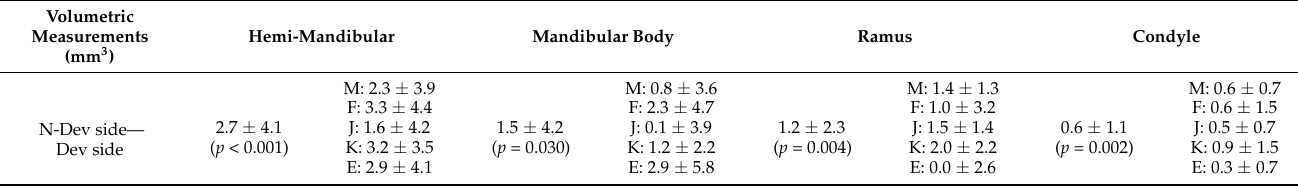
Table 5. Volumetric